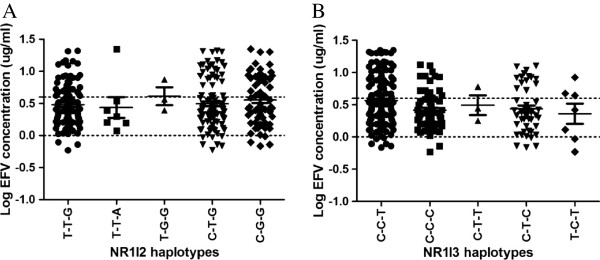
A-B: Effects of NR1I2 and NR1I3 haplotypes on plasma efavirenz concentration. The therapeutic range for efavirenz is shown. NR1I2 C-T-T and NR1I3 T-C-C haplotypes were only observed once and thus excluded from the analysis.